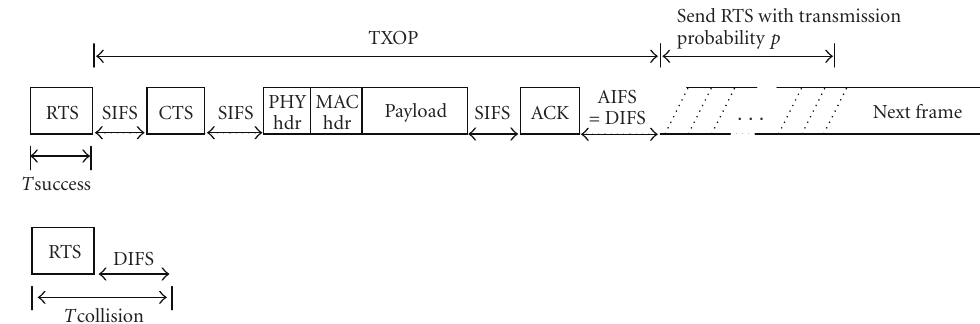
Figure 1: Timing diagram with RTS/CTS for our proposed